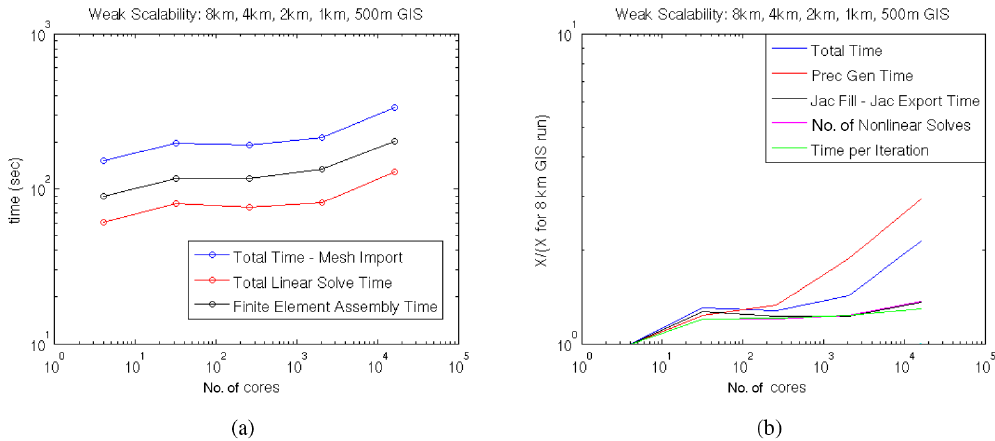
Figure 13. Controlled, weak scalability study on Hopper : (a) total linear solve, finite element assembly, and total run times in seconds, and (b) additional timing information ( X = time or number of